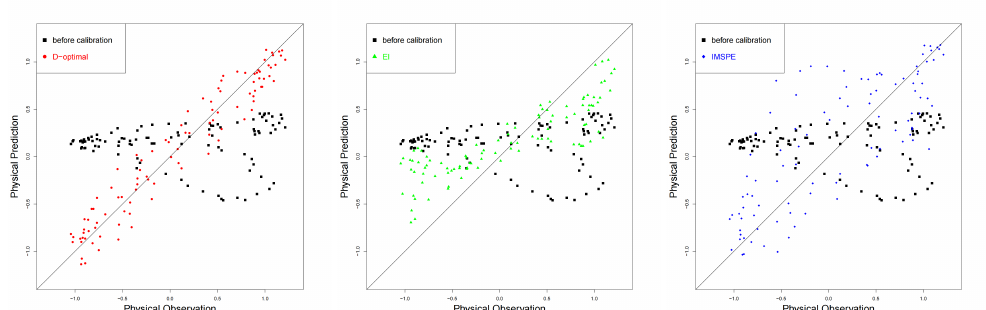
Figure 4. Physical predictions before and after calibration with the proposed sequential D-optimal method, EI method, and IMSPE method with 30 sequential computer experimental points.